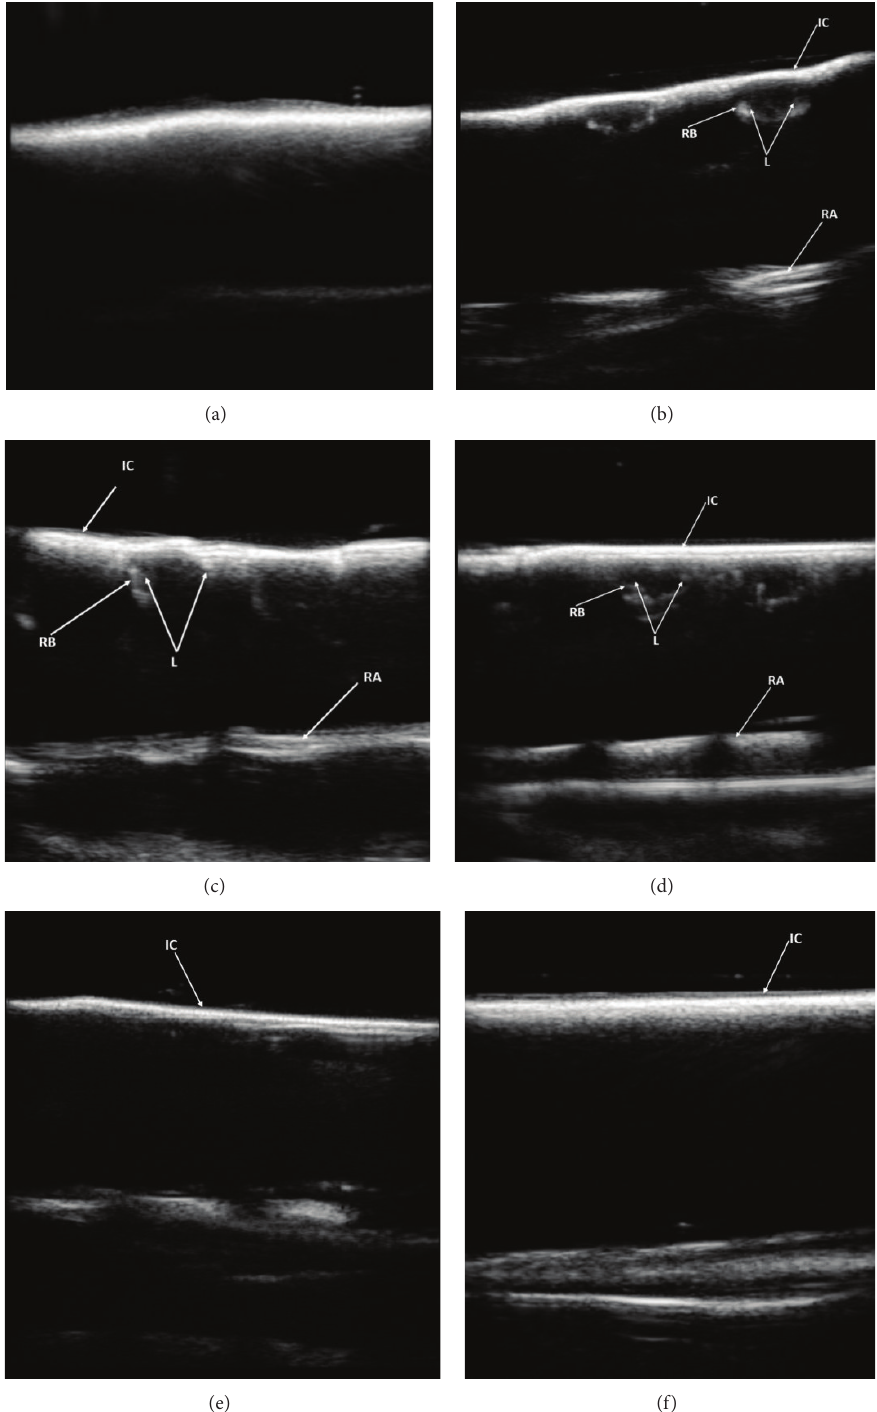
Figure 6: (a) Ultrasonogram of intact bone without any lesion. Ultrasonograms of sample: (b) number 1, (c) number 2, (d) number 11, (e) number 12, and (f) number 20. IC (intact cortical bone), RB (remaining bone between cavities), RA (reverberation artifact), and L